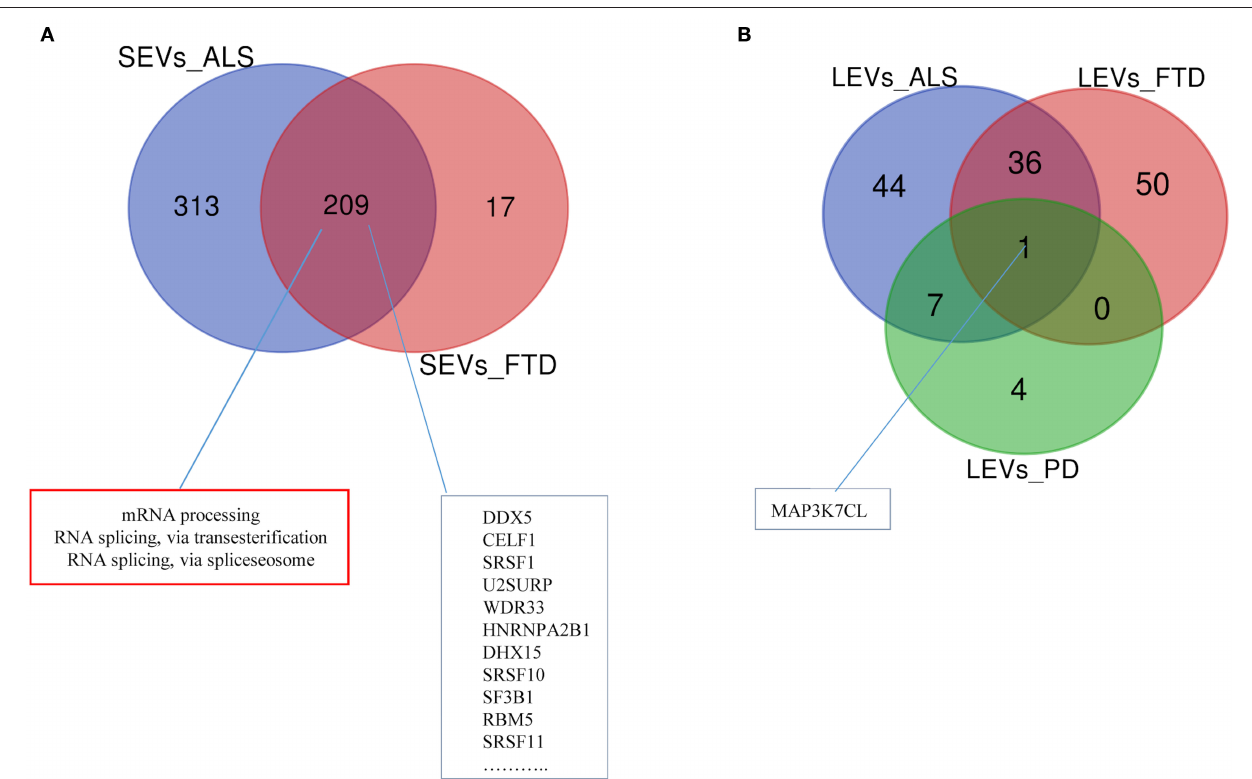
FIGURE 5 | Venn diagram showing numbers of common and unique RNA in SEVs from plasma of patients with ALS and FTD (A) and in LEVs from plasma of ALS, FTD, and PD (B) . Common mRNAs and pathways are listed. Differential mRNA expression analysis was carried out using DESeq2 (log2FC > 1, p < 0.05).